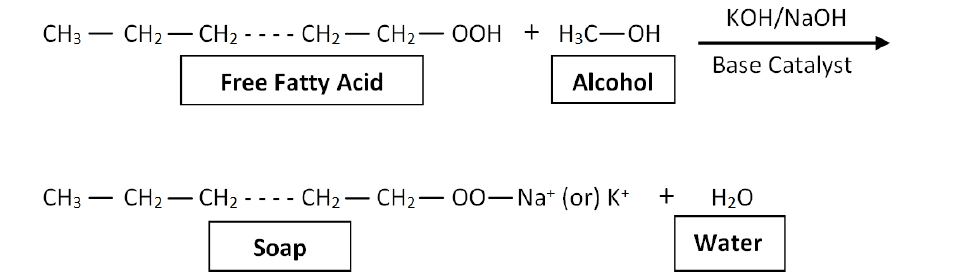
Figure 3. Soap formation